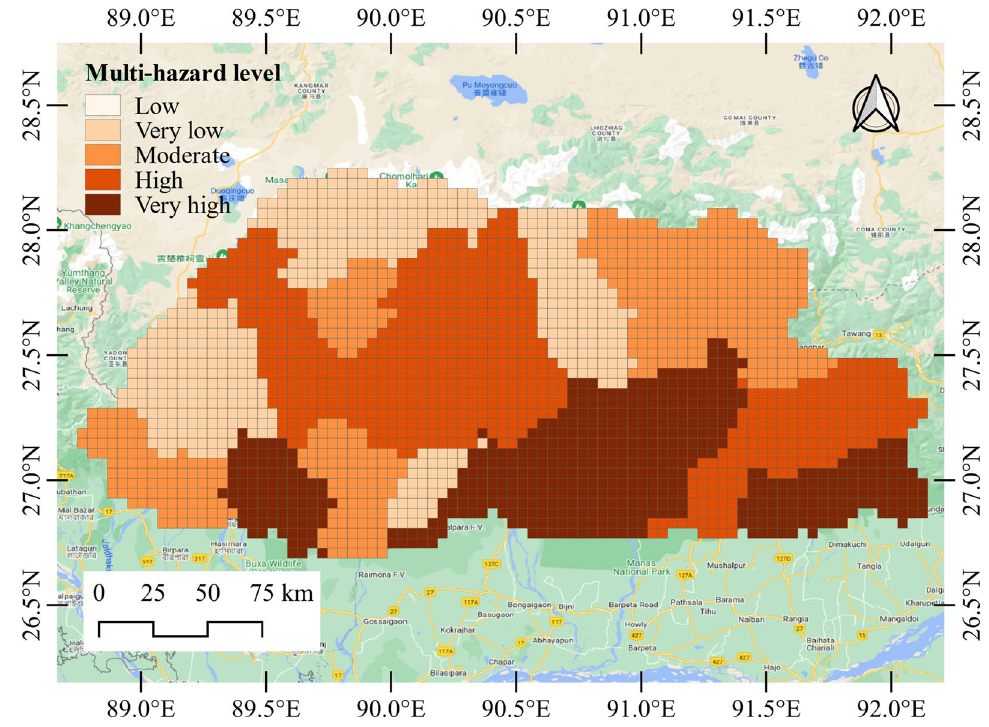
Fig. 8 District-level multi-hazard zonation of Bhutan